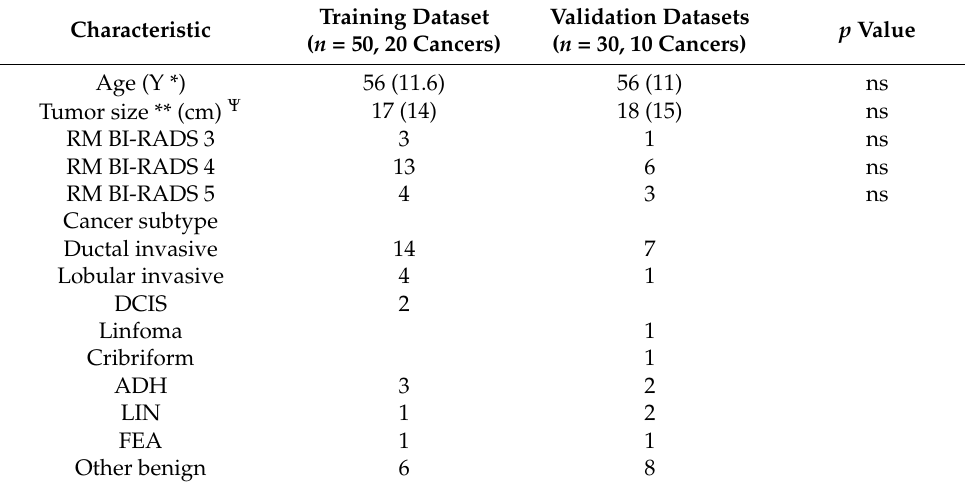
Table 1. Clinical and Pathologic Characteristics of Patients for Radiomics Model Construction. * Data are mean ± SDs, with ranges in parenthesis. ** For patients with positive histology. Ψ Kruskal–Wallis H test was performed. ns: not significant. DCIS: ductal carcinoma in situ. ADH: atypical ductal hyperplasia. LIN: lobular intraepithelial neoplasia. FEA: flat epithelia atypia. Training Dataset Characteristic ( n = 50, 20